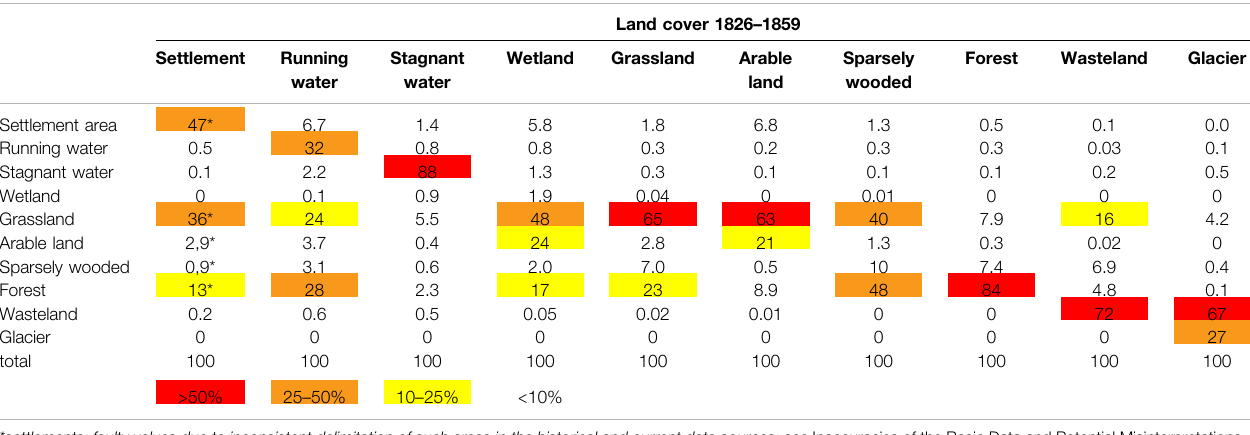
Frontiers in Environmental Science |